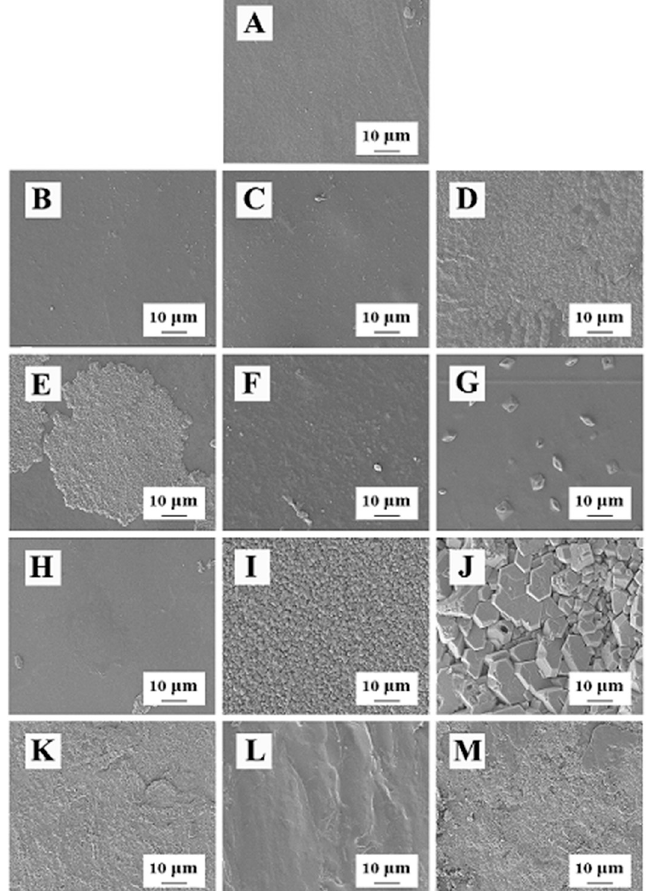
Figure 2. The microstructure of the composite films ( A ): CMBC/SA/Gl; ( B ): CMBC/SR/Gl; ( C ): CMBC/XG/Gl; ( D ): CMBC/GEL/Gl; ( E ): CMBC/SA/SO; ( F ): CMBC/SR/SO; ( G ): CMBC/XG/SO; ( H ): CMBC/GEL/SO; ( I ): CMBC/SA/PEG 400; ( J ): CMBC/SR/PEG 400; ( K ): CMBC/XG/PEG 400; ( L ): CMBC/SA/PEG 6000; ( M ): CMBC/SR/PEG 6000).